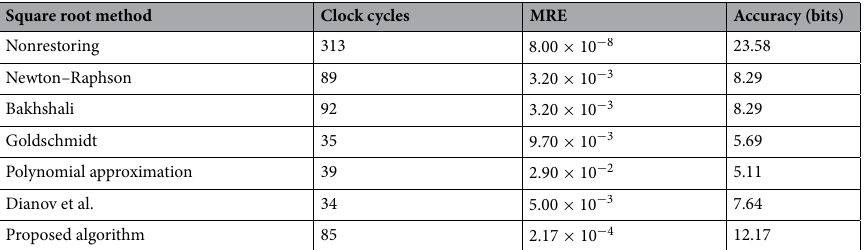
Table 7. Maximum relative error and accuracy values of selected methods including our proposed algorithm for square rooting. The number of clock cycles, required by each method, is also provided for comparison purposes. For our proposed algorithm, a LUT size of 1 KB and a 16-bit precision of cos θ values are